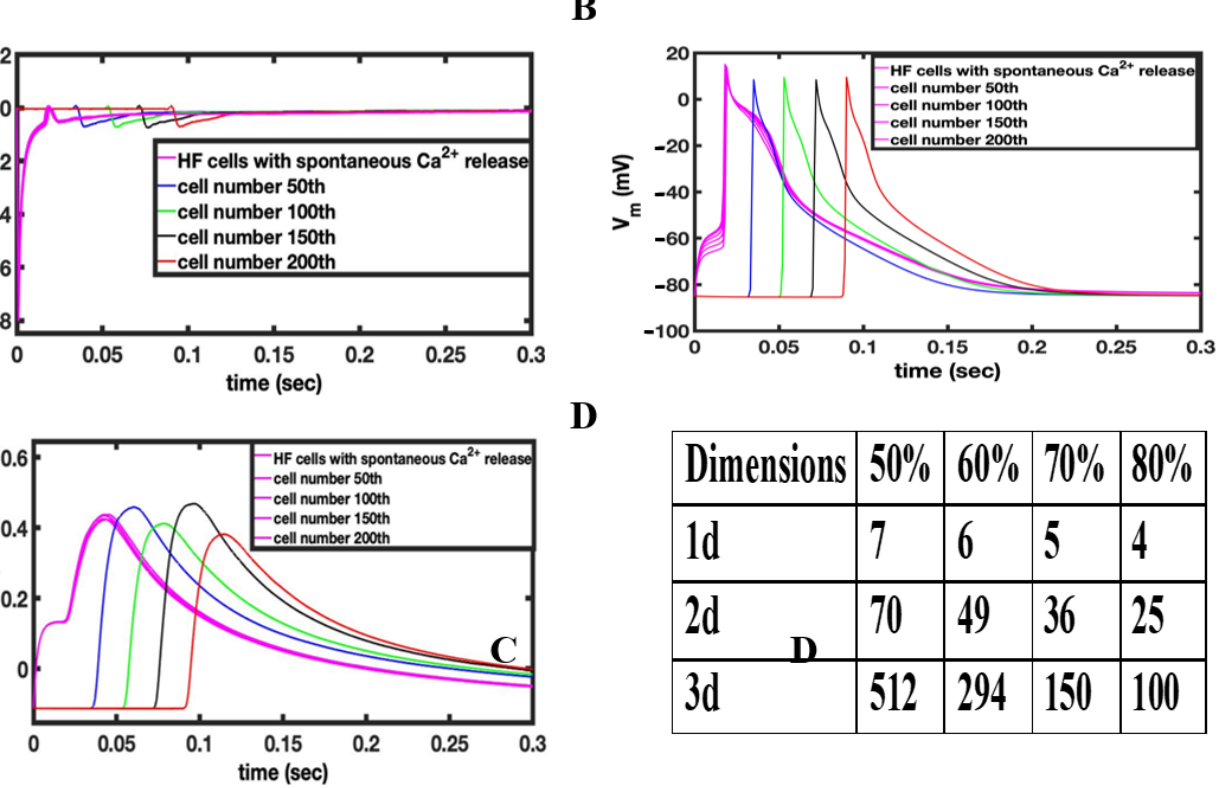
Figure 4. ( A ) Changes in I NCX during the depolarization of myocytes due to the activating Ca 2+ release. ( B ) Under HF conditions, opening 10 RyR2 channels in 50% of the release units results in a propagating action potential. ( C ) The Ca 2+ rises slowly in the triggered myocytes resulting in depolarization. The action potential spreads rapidly to other myocytes activating calcium release. ( D ) Table showing dependence of number of myocytes to propagate AP as a function of the fraction of activated Ca 2+ release units in 1-D, 2-D, and 3-D tissue. Table 2. The number of myocytes needed to trigger propagation of action potential.